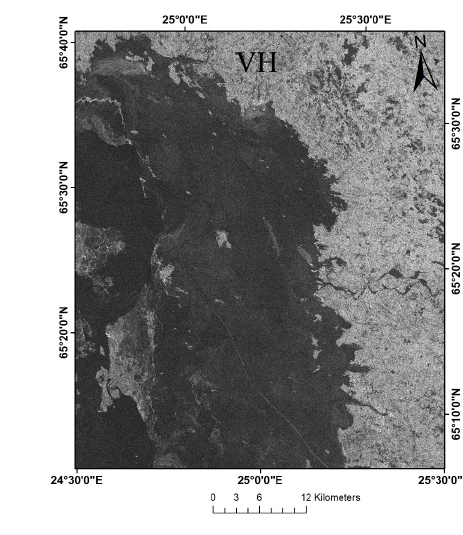
16 of 20 Figure 11. Comparison of the land–water boundary. The blue and red solid lines represent the land- water boundary and NOAA global coastline, respectively. Similarly, statistical parameters of distance from the land–water boundary to the NOAA global coastline are calculated as shown in Table 3. And a frequency histogram of sampling points (Figure 12) is generated to analyze the distance distribution. The statisti- cal results show that over the 345 km long coastline, the mean distance from the land- water boundary to the coastline data is 109.1 m, the standard deviation is 99.8 m, and 84% of the sampling points are within 200 m. The validation of results illustrates the stability and reliability of the method used in the mapping tasks of the land–water boundary.